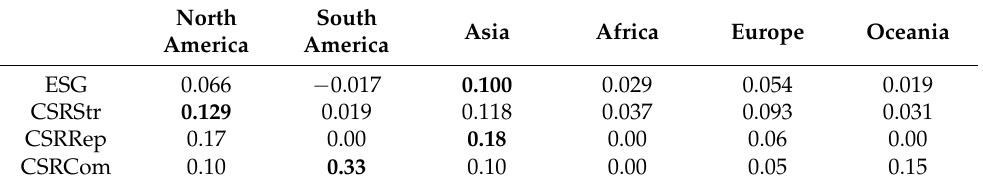
Table 4. Evolution of CSR variables from 2015 to 2019 (in